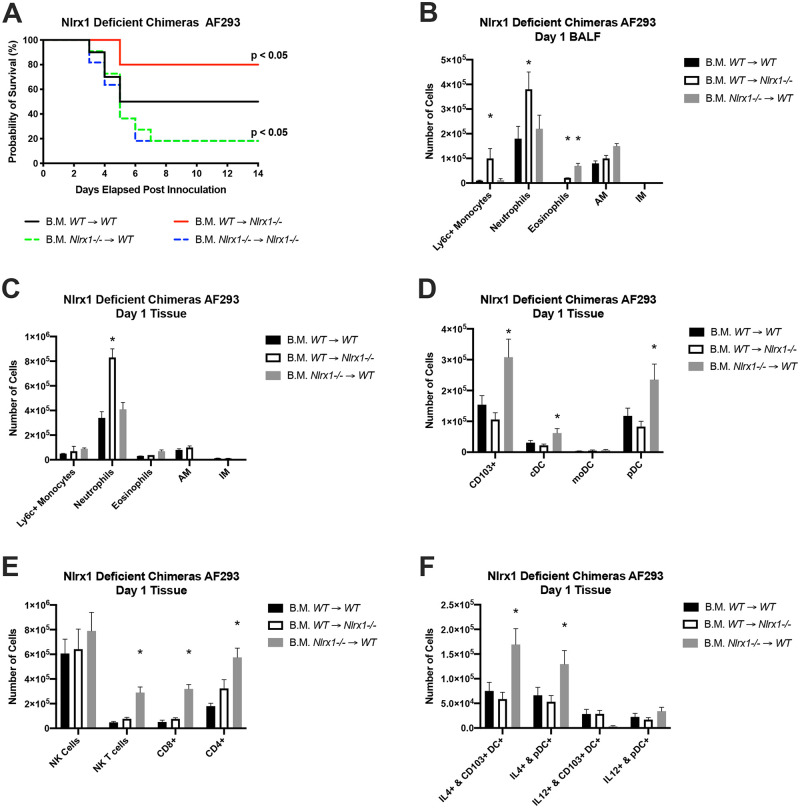
Loss of Nlrx1 in either radio-sensitive and insensitive cells populations impacts survival and immune cell recruitment.Wild type and Nlrx1-/- mice were irradiated and replenished with bone marrow from healthy wild type or Nlrx1-/- mice. Mice were allowed to recover for 6–8 weeks prior to inoculation. (A) Kaplan-Meier survival curve for neutrophil depleted chimeric mice inoculated with AF293 via non-invasive tracheal instillation AF293 conidia (107 conidia/ 25μL). Mice were immuno-suppressed on day 1 prior and day 3 post inoculation using IP injection of Ly6G antibody (Clone A18). Statistical significance was determined using the log-rank (Mantel-Cox) test. N = 10 experimental group. (B-F) FACS analysis of immune cell populations from bronchoalveolar lavage fluid BALF and pulmonary tissue from immuno-competent chimeric mice on day 1 post inoculation were determined by FACS. Asterisk denotes statistical significance, P < 0.05 Mann-Whitney U test. Error bars indicate standard deviation. N = 8–10 per experimental group. AM, alveolar macrophages. IM, interstitial macrophages. DC, dendritic cells. pDC, plasmocytoid dendritic cells. moDC, monocytoid dendritic cells. cDC, conventional dendritic cells. NK, natural killer cells. NKT, natural killer T cells. CD8+, CD8+ T cells. CD4+, CD4+ T cells.